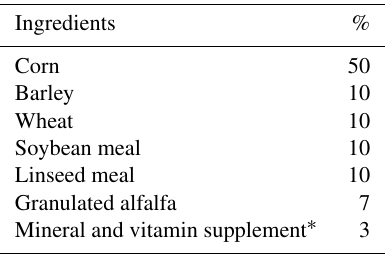
Table 1. The composition of complete feed mixture in Slovakia.